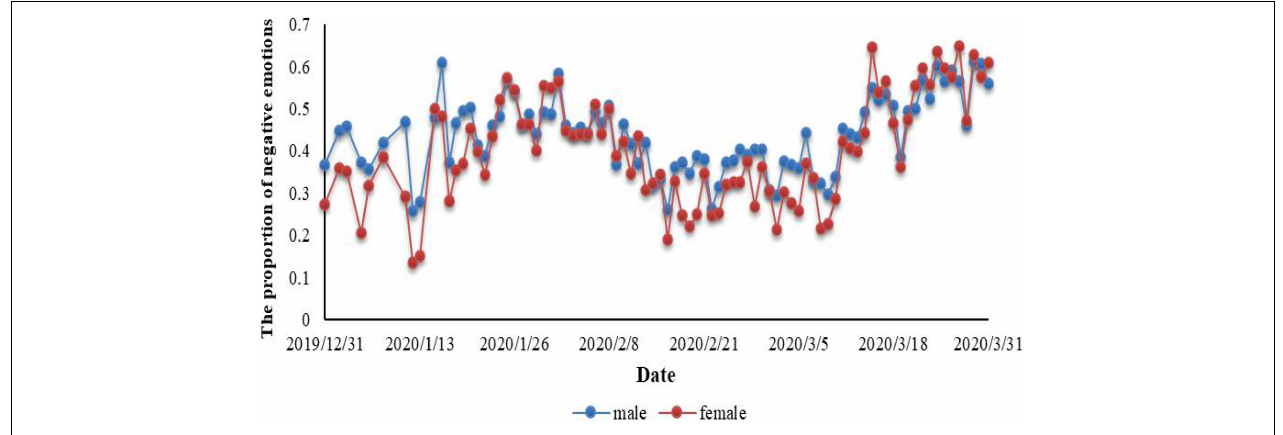
FIGURE 7 | Gender differences in the proportion of negative emotions.